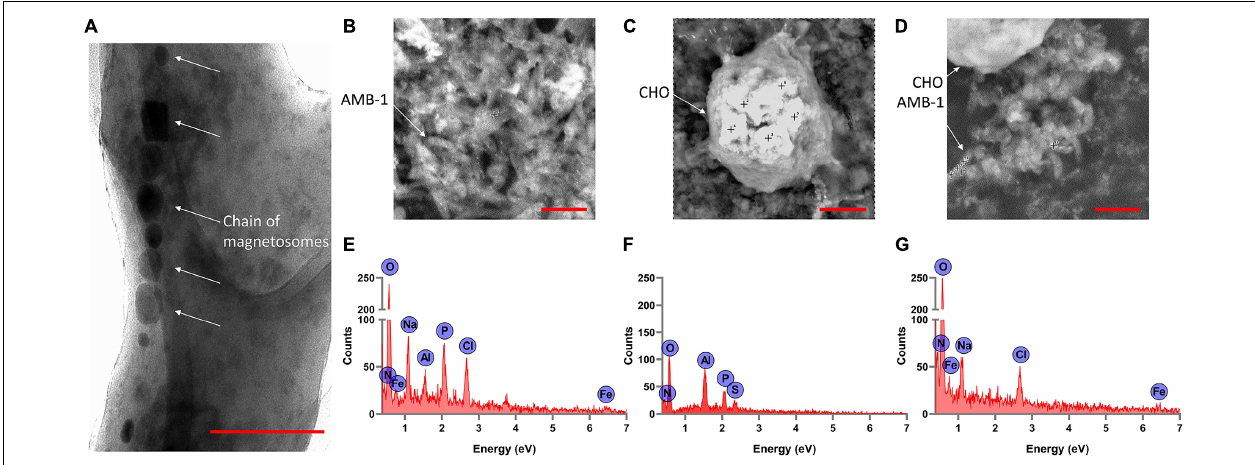
FIGURE 3 | Characterization of individual AMB-1 cells and AMB-1/CHO cell interactions using TEM and SEM. (A) TEM analysis of AMB-1 shows the presence of the chain of magnetosomes, as pointed out by the white arrows (scale bar = 0.1 µ m for A); SEM images of (B) AMB-1 control, (C) CHO control, and (D) AMB-1 with CHO cells [scale bar = 2 µ m for panels (B,D) and 3 µ m for panel (C) ] (the “+” sign on the SEM images shows the spots at which EDAX spot analysis is performed); EDAX analysis of (E) AMB-1 control, (F) CHO control, and (G) AMB-1 with CHO cells (signal from carbon has been removed to make the low-intensity peaks more